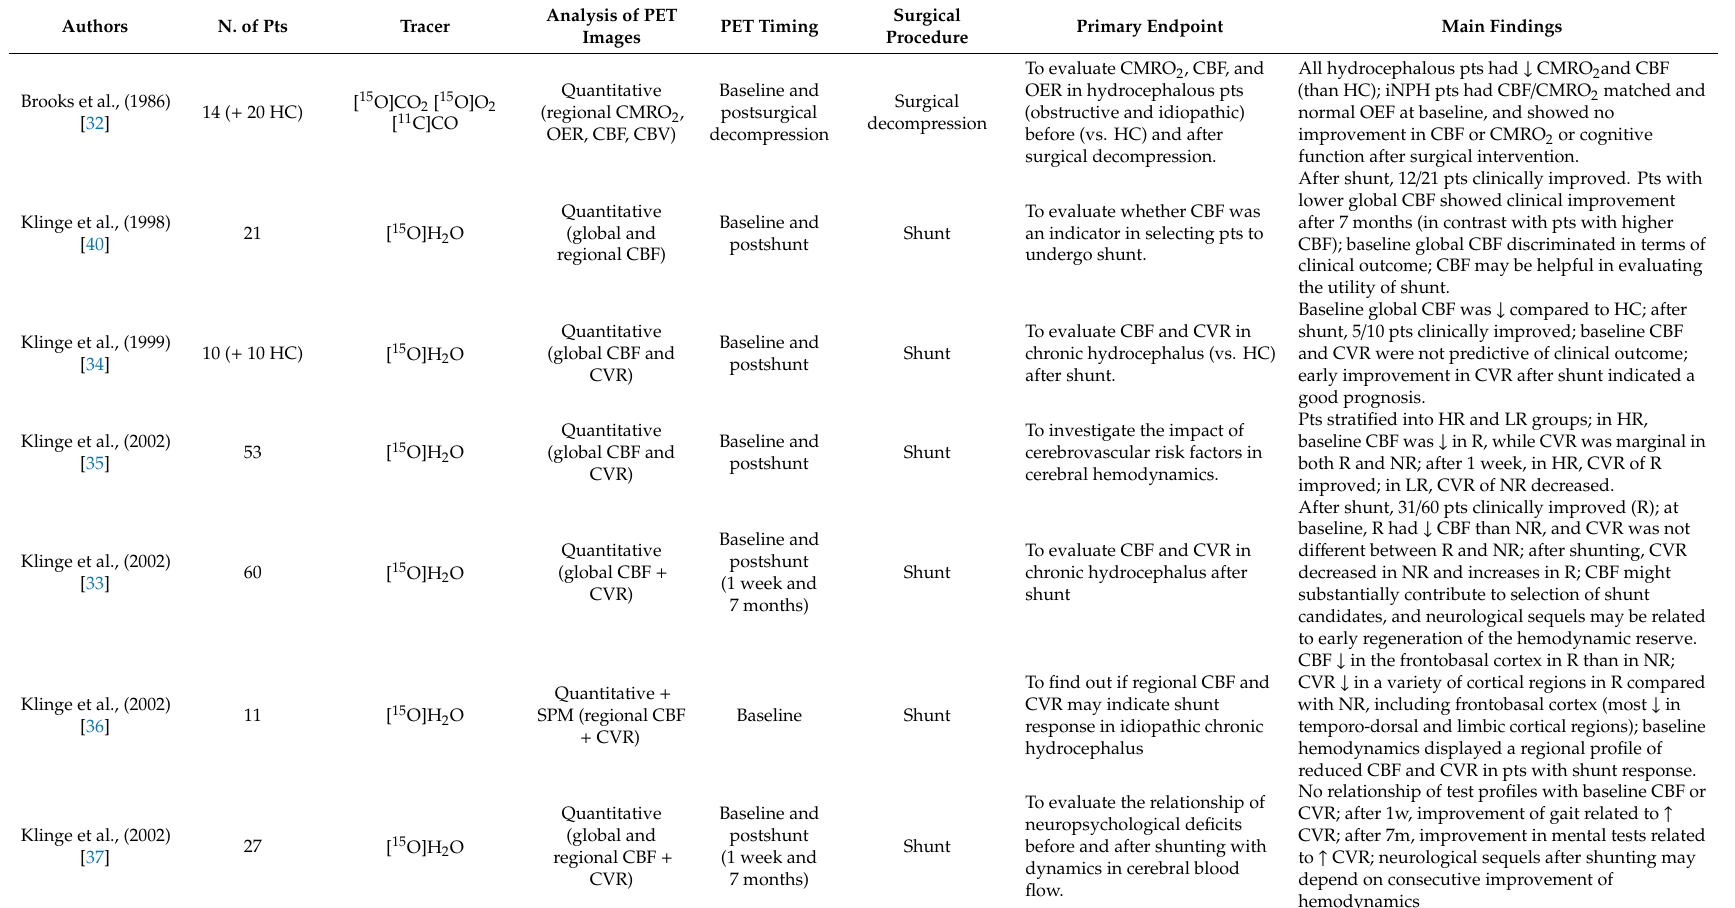
Table 2. Perfusion PET imaging in NPH